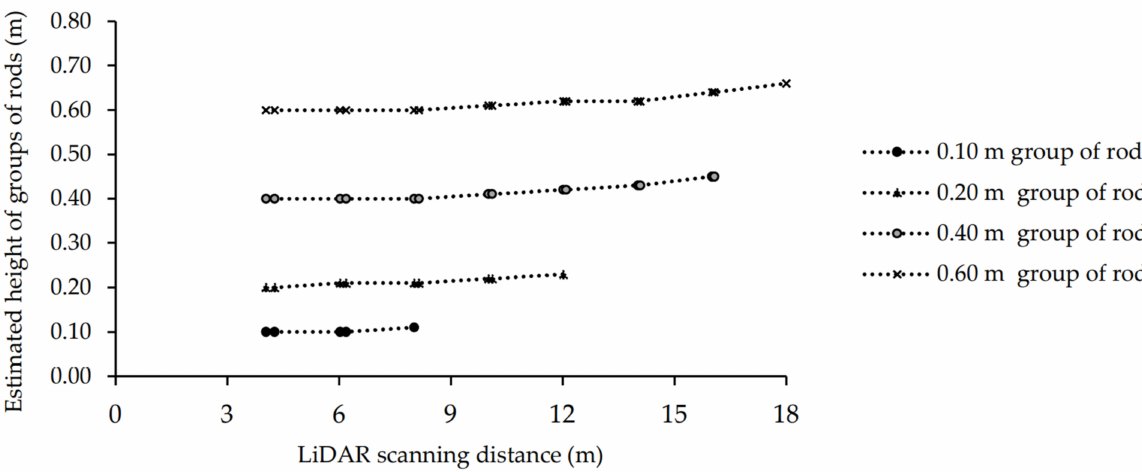
Figure 6. Comparison of the actual height (0.10, 0.20, 0.40 and 0.60 m) and LiDAR-estimated heights at different scanning distances of 4 to 16 m for the groups of